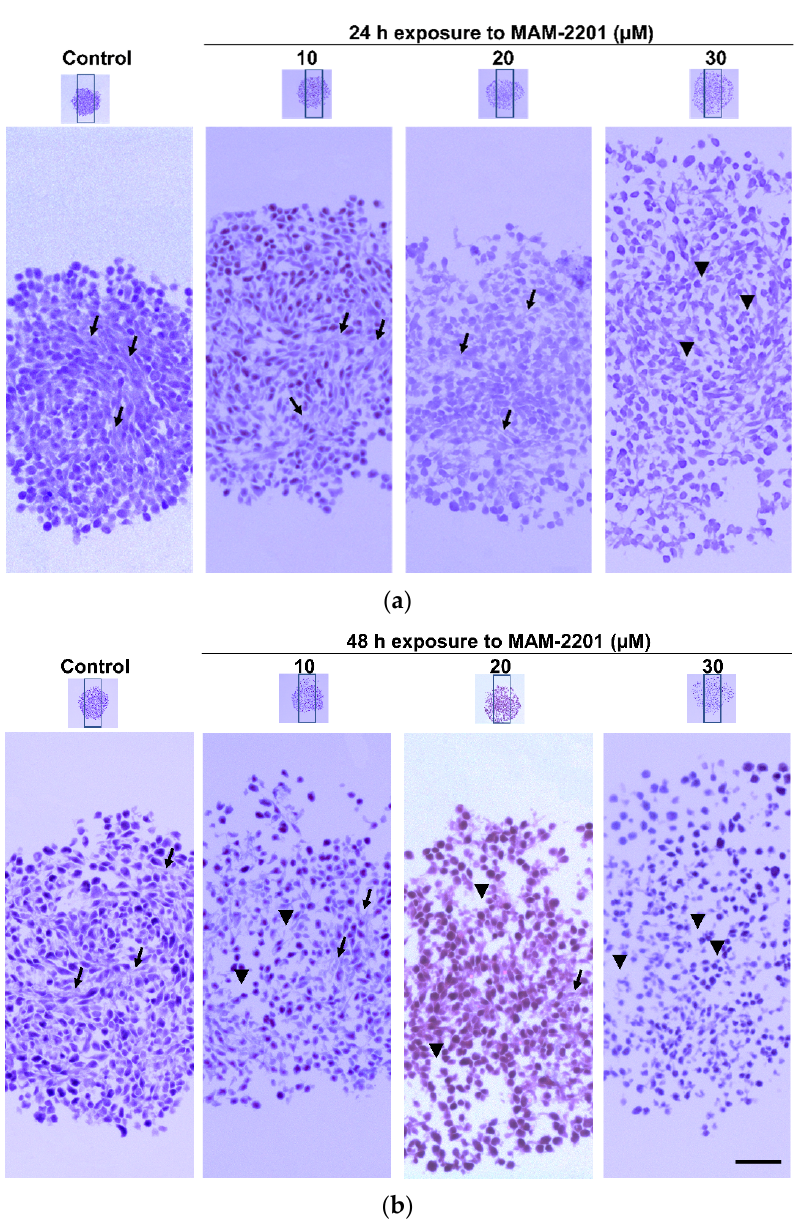
Figure 4. Masson’s trichrome staining. Representative images of trichrome staining in D384 spheroid section treated with or without MAM-2201 after 24 h ( a ) and 48 h ( b ). The rectangle indicates the magnification (10 × ), black arrows indicate the ECM, and the arrow head indicates the empty spaces (reduction in the amount of collagen fibers). Scale bar: 100 µ